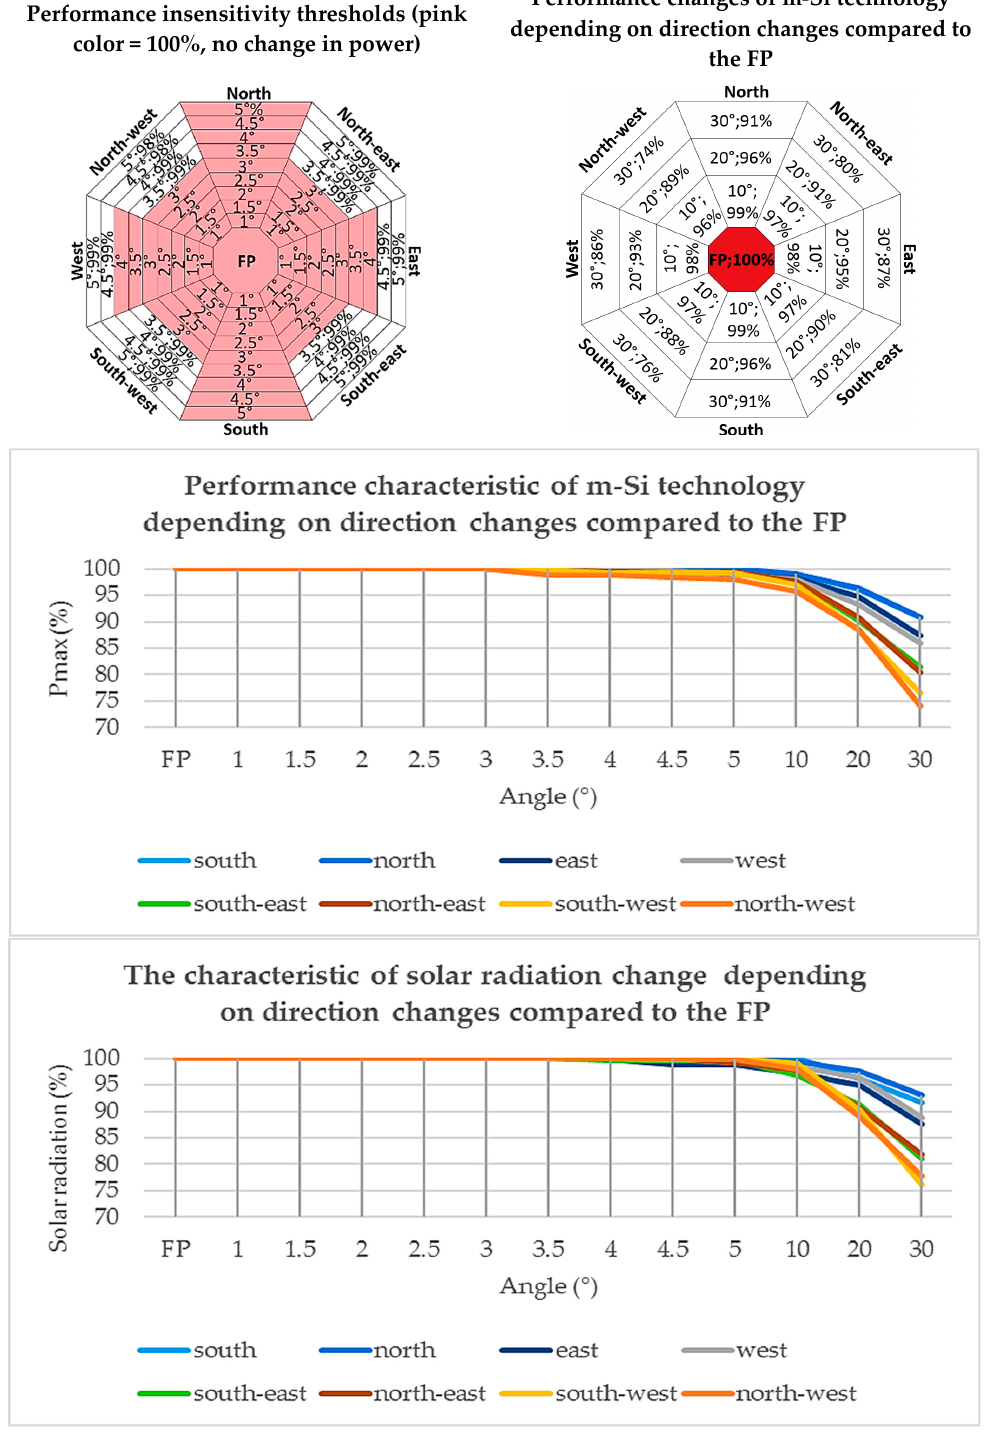
Figure 8. The performance insensitivity thresholds, the performance changes, the solar radiation features and the performance characteristics of m-Si technology depending on directional changes compared to the focus point (FP).